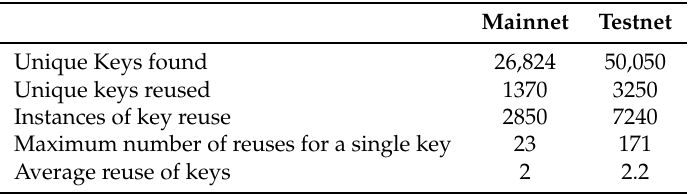
Table 3. Key reuse in channel graphs found in complete runs.